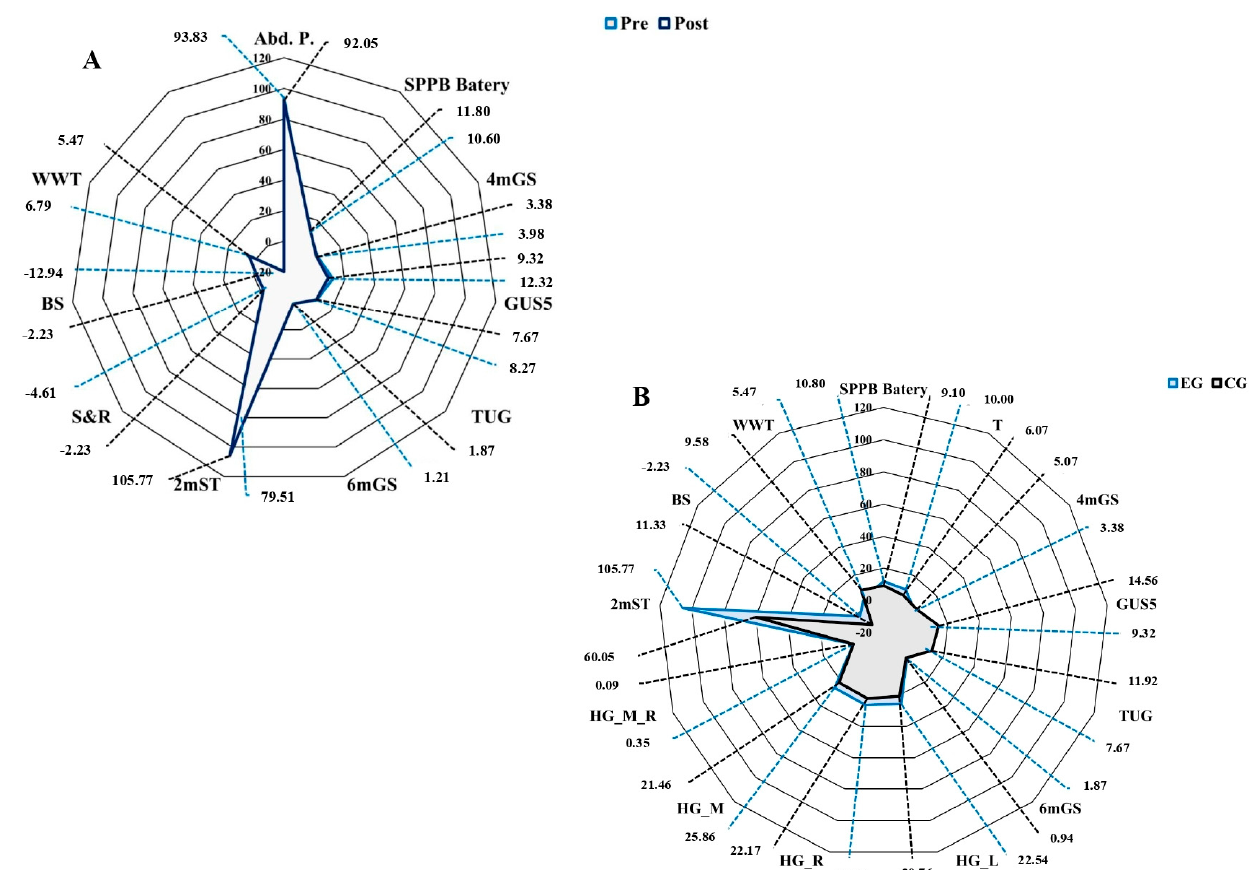
Figure 2. Spider chart showing the main differences in the functional capacity and physical capacity tests. Note: ( A ) EG. Comparison of the median significant values obtained for each test before and after the application of the MPTP. ( B ) Comparison between the experimental and control groups after the application of the MPTP program.